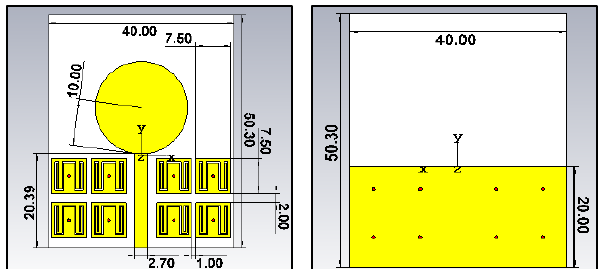
Figure 11. Spiral EBG unit cell simulation using suspended line method with wave ports (a) Top view (b) Bottom view